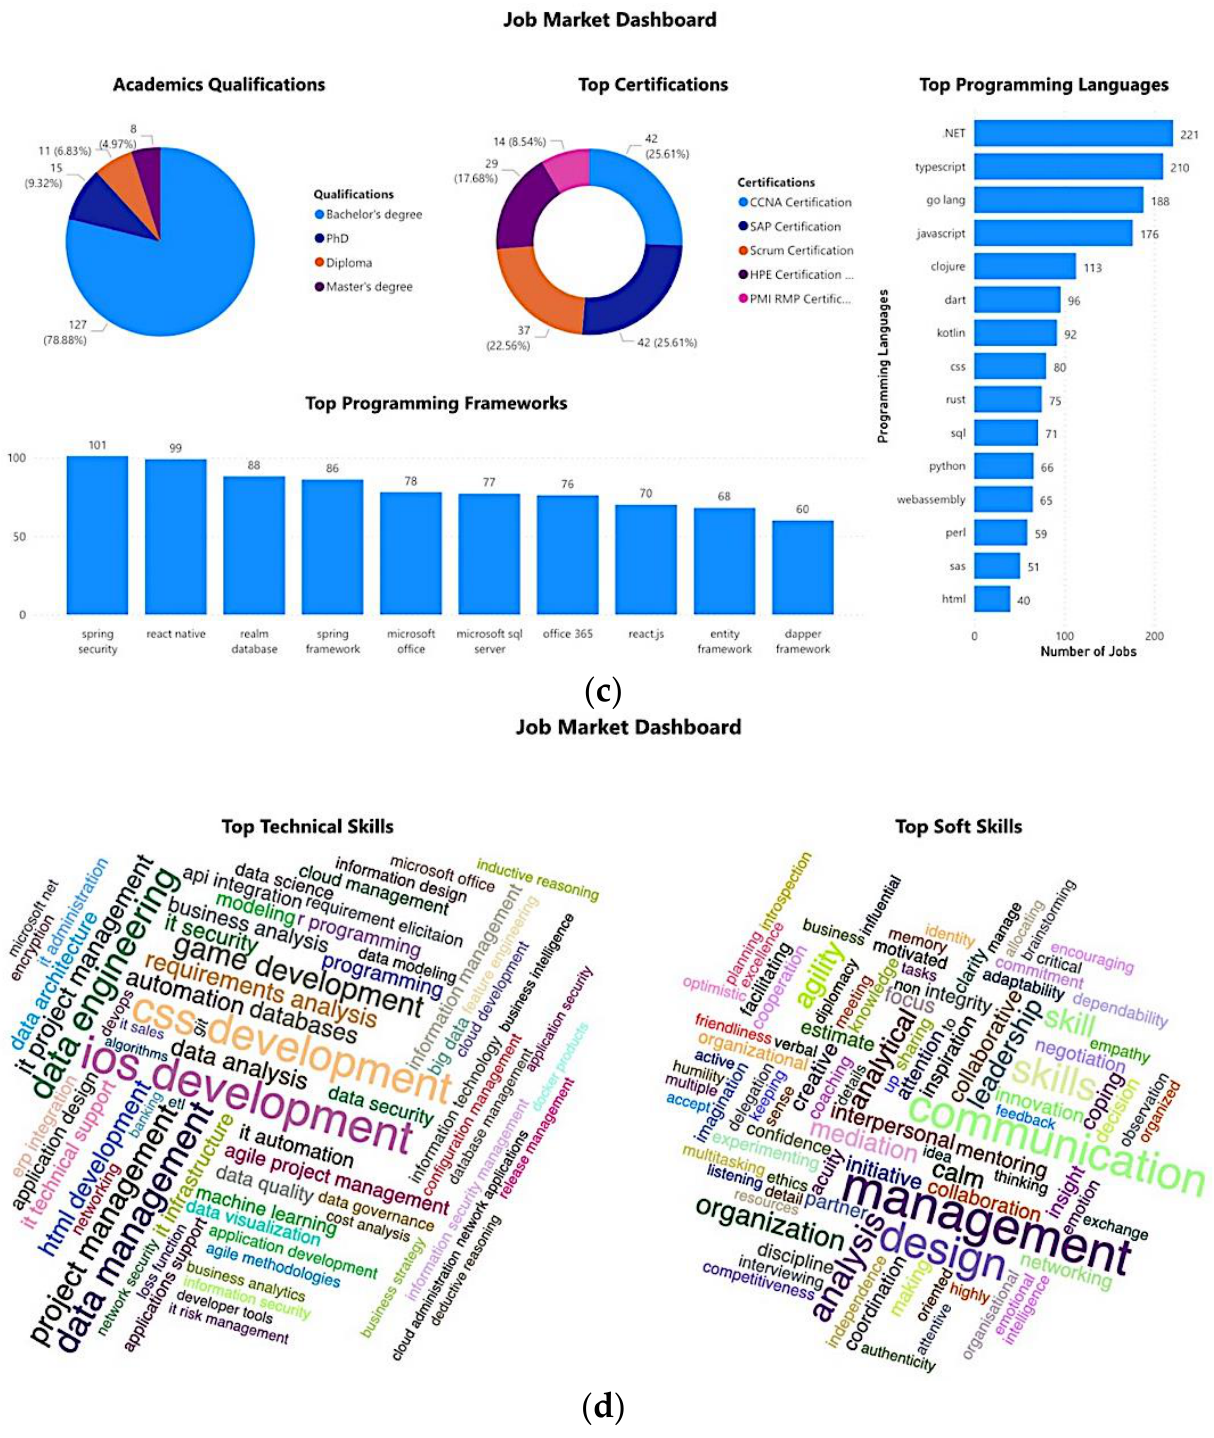
Figure 3. ( a ). Saudi job market dashboard across job sectors, career levels, and industries. ( b ) Saudi job market dashboard across locations. ( c ) Saudi job market dashboard across academic qualifications, certifications, programming languages and frameworks. ( d ) Saudi job market dashboard across technical and soft skills.